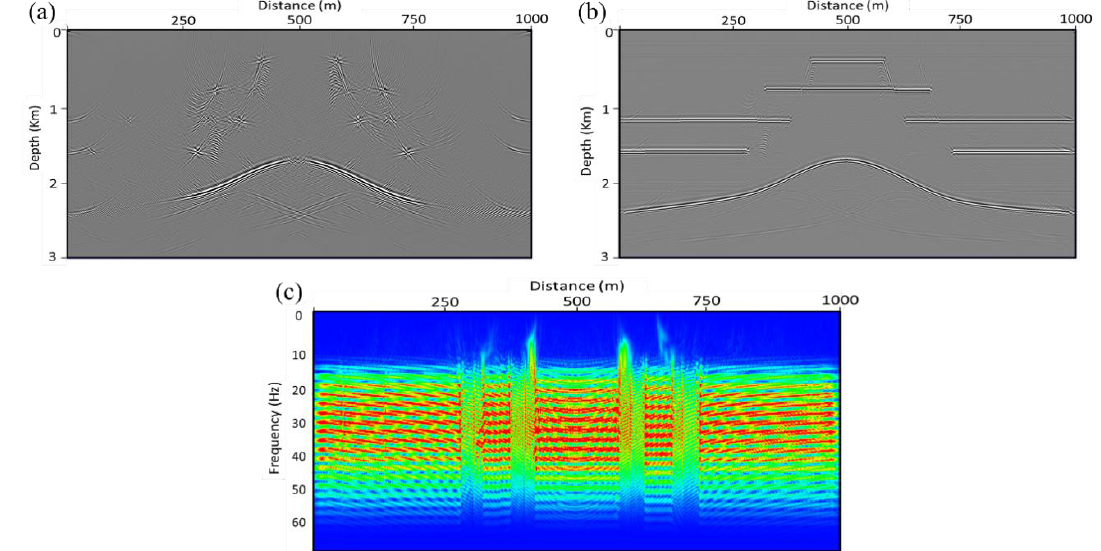
Figure 7. ( a ) Migrated seismic section, The point diffractor shows the location of the discontinuity and the fault indicator. ( b ) Full-wave seismic migrated section; all components of the fault are missing. ( c ) Amplitude spectrum (frequency bandwidth) of the migrated data, showing that the diffraction amplitude is biased.